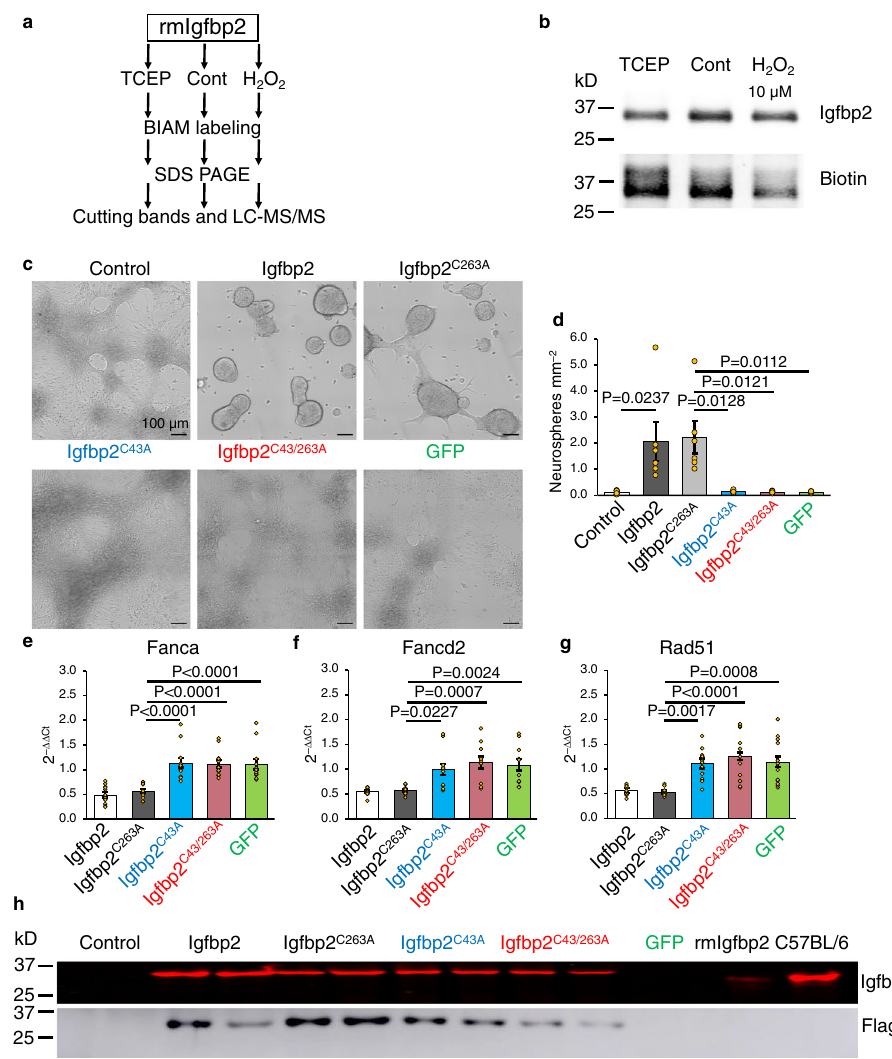
Fig. 5 | Ncf1/Igfbp2-mediated repression of NSC DNA repair pathways requires Igfbp2 C43 to promote neurosphere formation. a Experimental design. b Western blot analysis of untreated or TCEP- or H 2 O 2 -treated recombinant mouse Igfbp2 (rmIgfbp2) after labeling with biotinylated iodoacetamide (BIAM). c – h Igfbp2 – / – NSCs were transfected with Igfbp2, Igfbp2 C263A , Igfbp2 C43A , Igfbp2 C43/263A , or GFP expressing plasmid 24h after plating. c Photomicrographs of NSCs 11 days after transfection. d Quanti fi cation of neurospheres ≥ 60 µ m in diameter ( n =6 donors). e – g qPCR of Fanca ( e ), Fancd2 ( f ) and Rad51 ( g ) in Igfbp2 – / – NSCs 5 days after